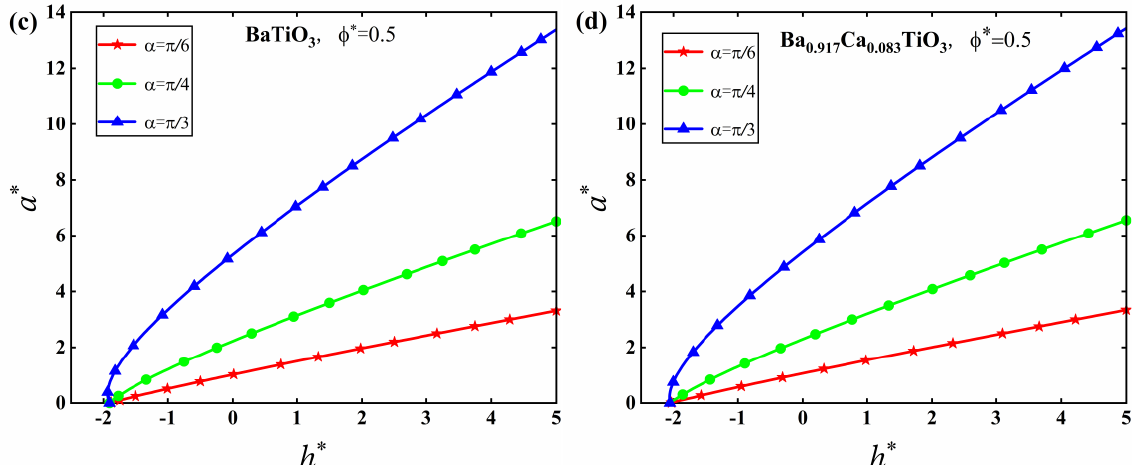
Figure 11. Variation of the dimensionless contact radius, a ∗ , with the dimensionless indentation depth, h ∗ , at different values of α = π /6, π /4 and π /3 for the conducting punch with non-zero electric potential ( φ ∗ = 0.5). ( a ) PZT-4. ( b ) PZT-5A. ( c ) BaTiO 3 . ( d ) Ba 0.917 Ca 0.083 TiO 3 .